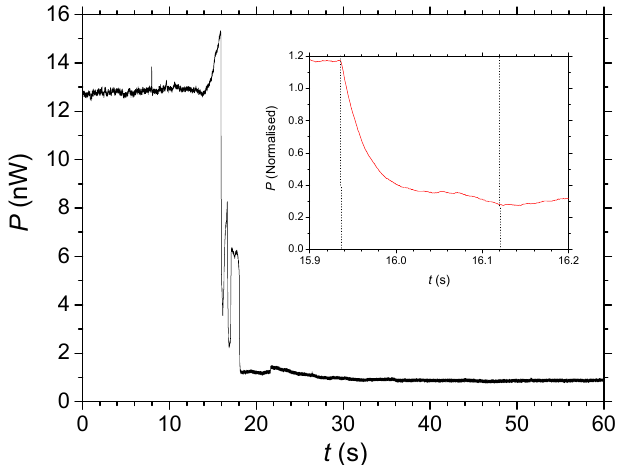
Figure 5. Optical transmission of 632 nm through a self-assembled wire as a function of time during percolation of Rhodamine B using the setup illustrated in Figure 4. Inset shows a close-up of the initial attenuation the signal has been normalized to the initial signal level